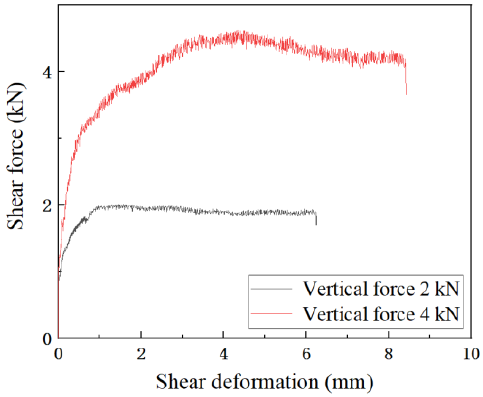
Figure 13. Load – displacement curve for the mortar shear test.